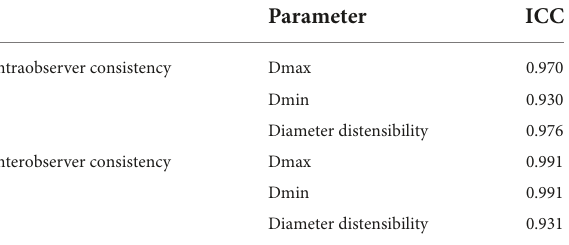
TABLE 1 The results of the repeatability